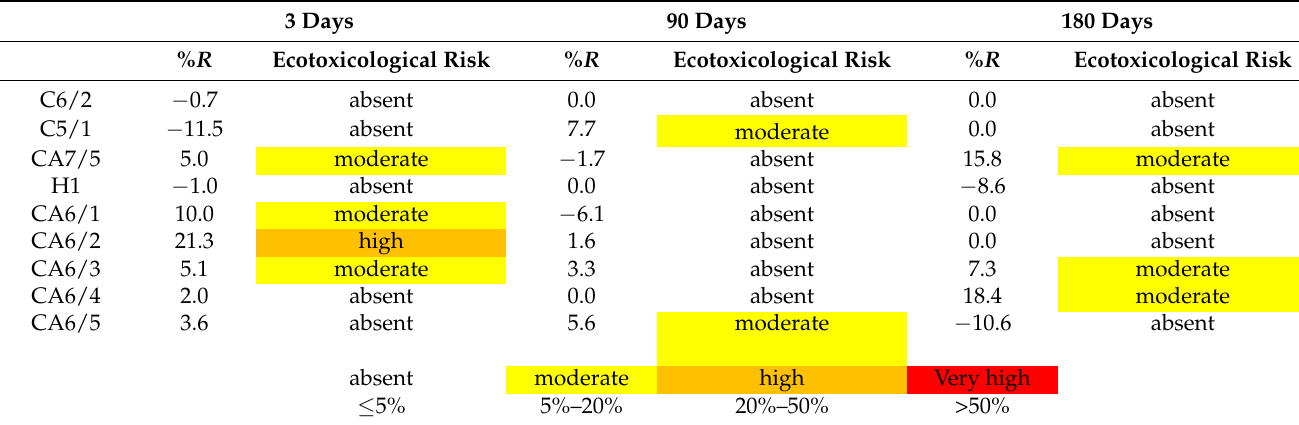
Table 3. Results after integration of values from bioassays performed in saltwater: percentage of ecotoxicological risk (%) and the corresponding ecotoxicological risk level (from absent to very high).